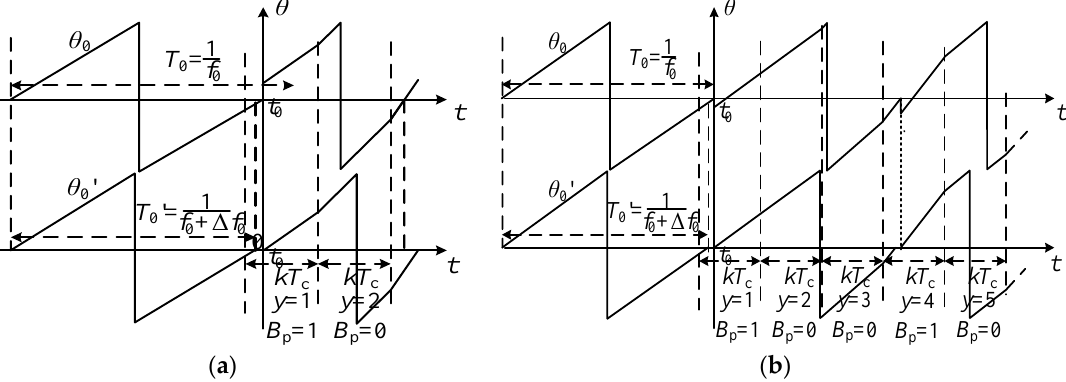
Figure 5. The change of θ 0 and θ 0 ′ in the condition that the disturbance tending to increase the current frequency. ( a ) The inductive load. ( b ) The capacitive load.